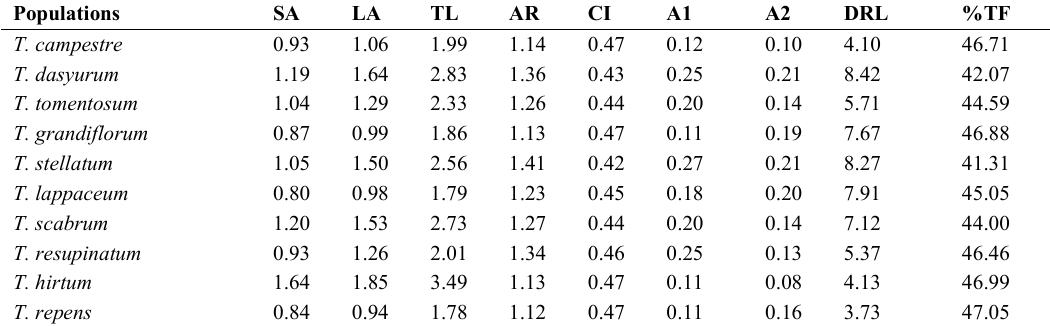
T. repens TL= total length of chromosome; LA= long arm; SA= short arm; AR= arm ratio; CI= centromeric index; DRL= difference of relative length; TF%= total form percentage; A 1 = intra-chromosome asymmetry index; A 2 = inter-chromosome asymmetry index.